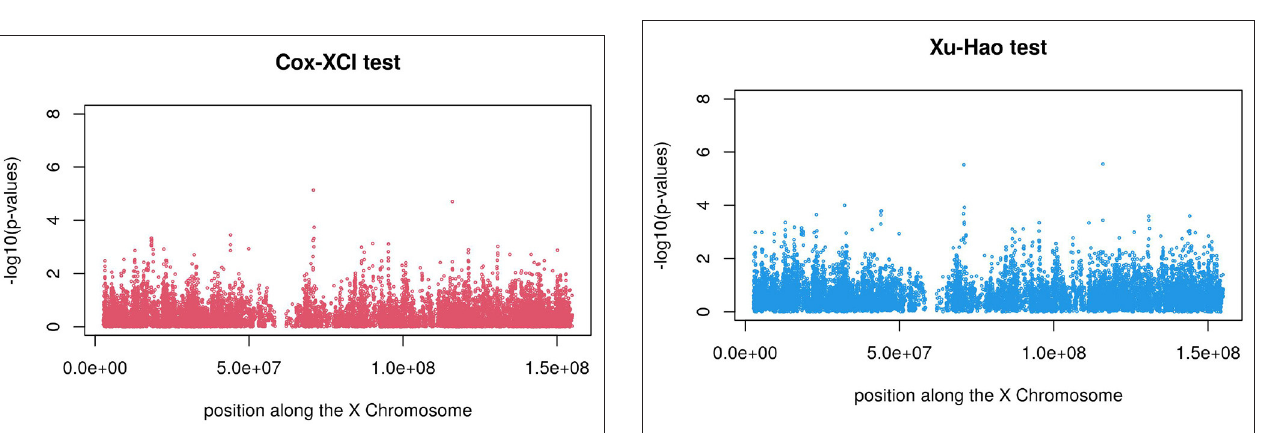
FIGURE 5 | Manhattan plot of X Chromosome genome-wide association results-Cox-XCI test.